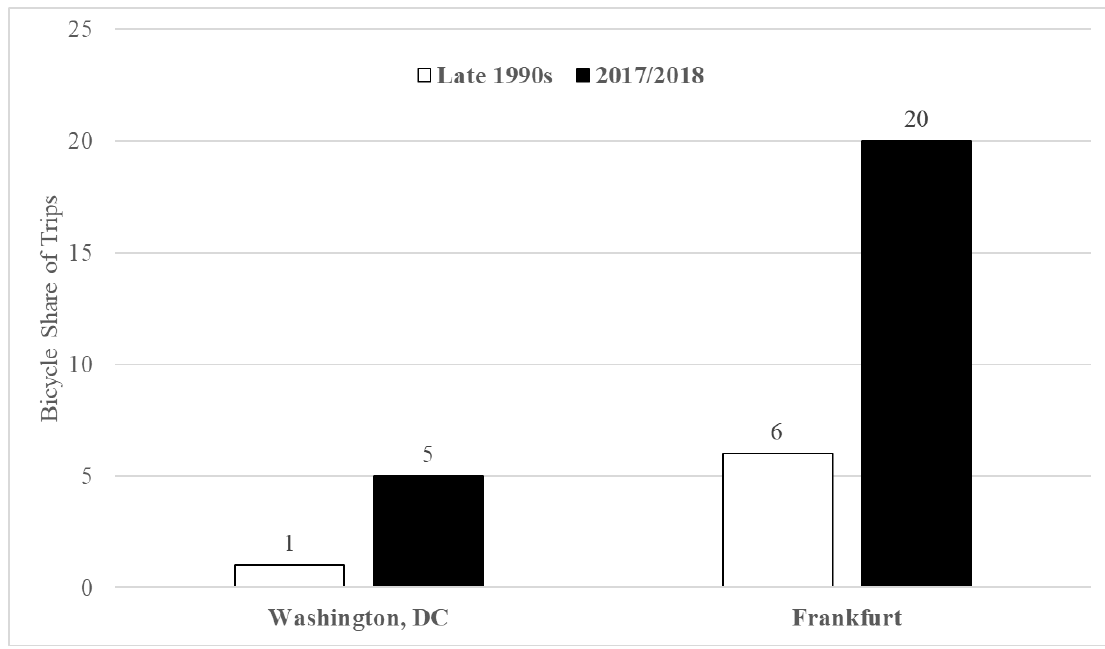
Figure 1. Trend in bicycle share of trips in Washington, DC and Frankfurt, Germany, between the late 1990s and 2017/2018. Note: The graph shows the share of trips by bicycle made by residents of each city. Source: [2,3].